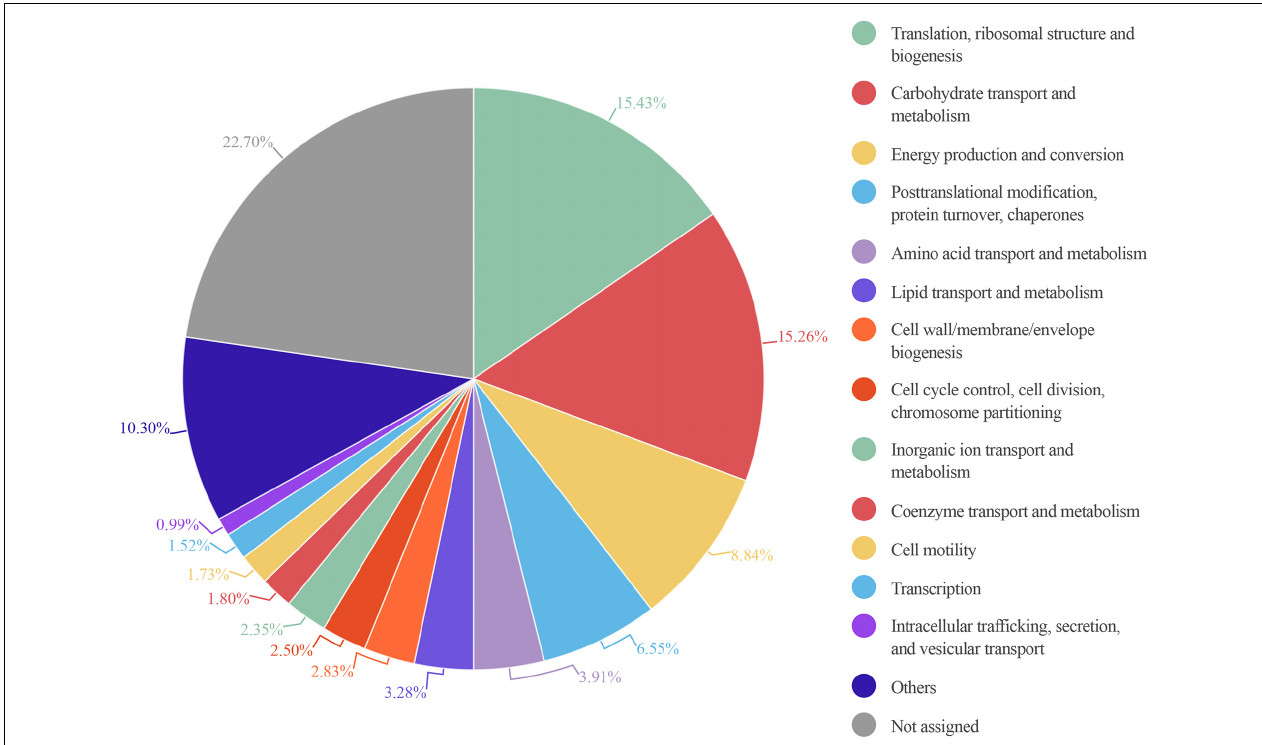
FIGURE 6 | Circle plot representation of the abundance of COG functional entries displayed by the identified gut microbiota proteins from six healthy adults. Abundance in each sample is calculated as the percentage resulting from summing up all intensities belonging to proteins annotated to a specific COG category in this sample/total intensity of all proteins annotated to any COG category in this sample. The mean of the COG category abundance of the six samples is